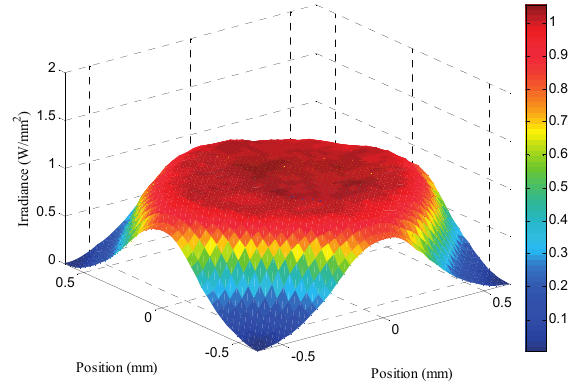
Figure 9. Optical efficiency of the Fresnel lens with SP-type SOE.